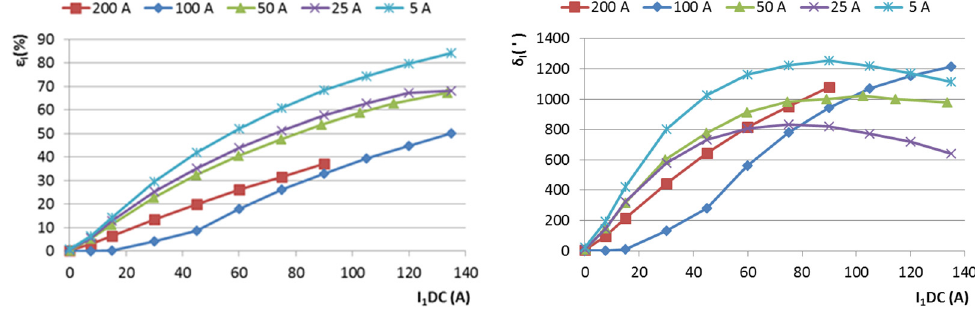
Figure 1. Ratio error ε I and phase error δ I of the 500 A/5 A current transformer CT1 as a function of the spurious DC current I 1DC . AC measured current I 1AC is a parameter.